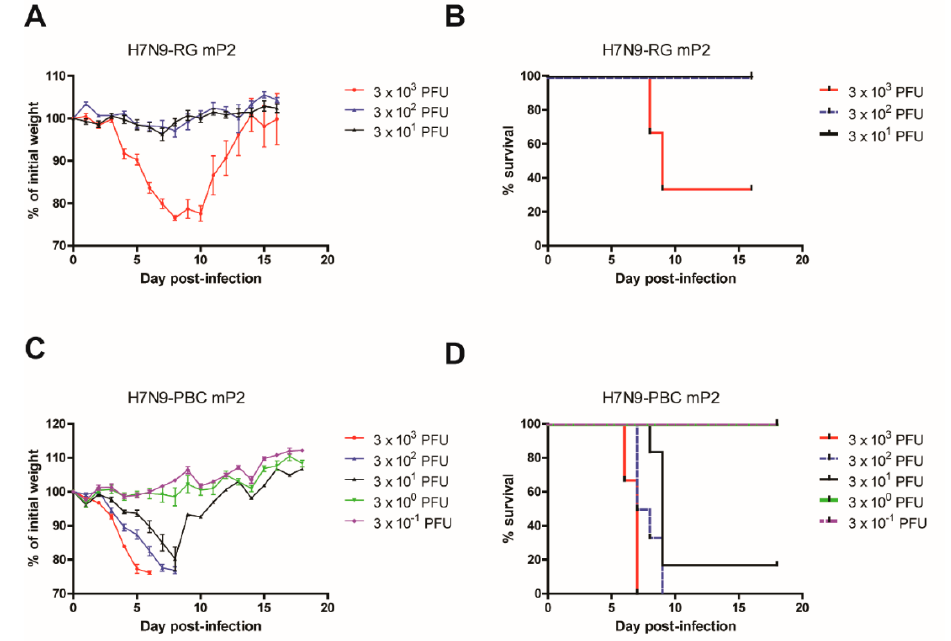
Figure 3. Determination of mouse median lethal dose (MLD 50 ) for mouse-passaged H7N9 viruses. Groups of mice ( n = 6) were infected intranasally with a dose range of 3 × 10 − 1 to 3 × 10 3 PFU of either H7N9-RG mP2 ( A , B ) or H7N9-PBC mP2 ( C , D ) viruses. Mean percent weight loss ± standard error of mean ( A , C ) and survival curves ( B , D ) for each virus are shown.